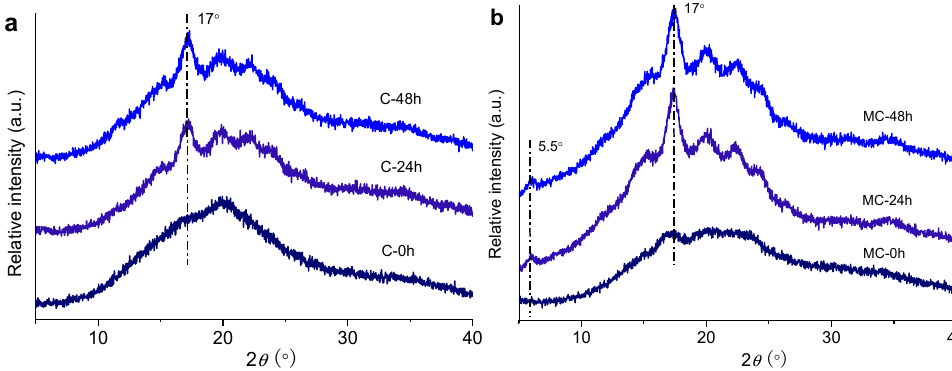
Figure 3. XRD diffractograms of conventionally (C) ( a ) and microwave-cooked (MC) ( b ) starches with different storage times (0, 24, or 48 h).